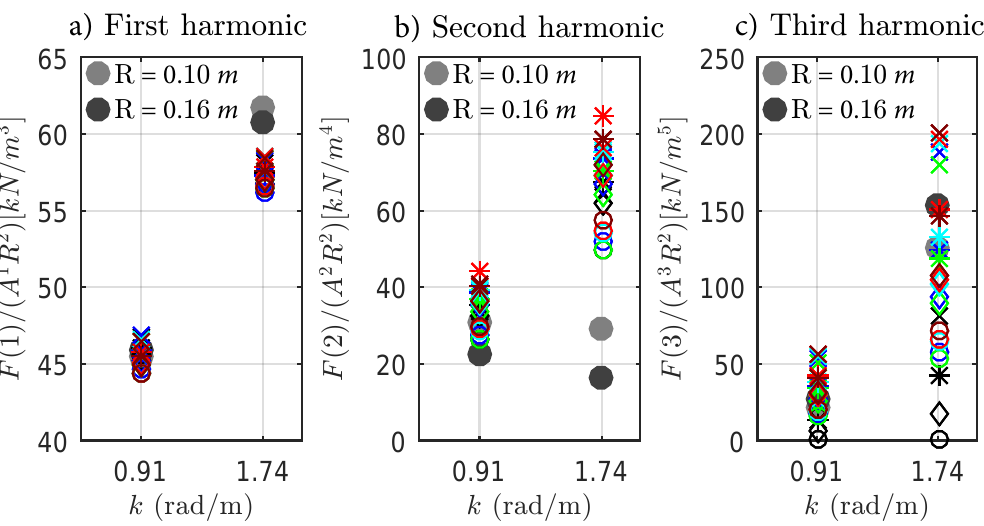
Figure 9. First ( a ), second ( b ) and third ( c ) harmonics of the normalized horizontal force over the increasing wave number kR for the two cylinders with steepness kA ≈ 0.232, compared with experiments from [21] (grey dots—lighter grey with smaller radius R = 0.1 m , darker grey with larger radius R = 0.1635 m